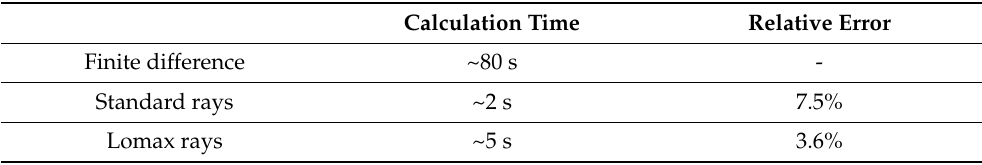
Table 1. Calculation times of wave field for one source on one processor core in the Sigsbee model and the error of the ray method relative to the result of finite difference